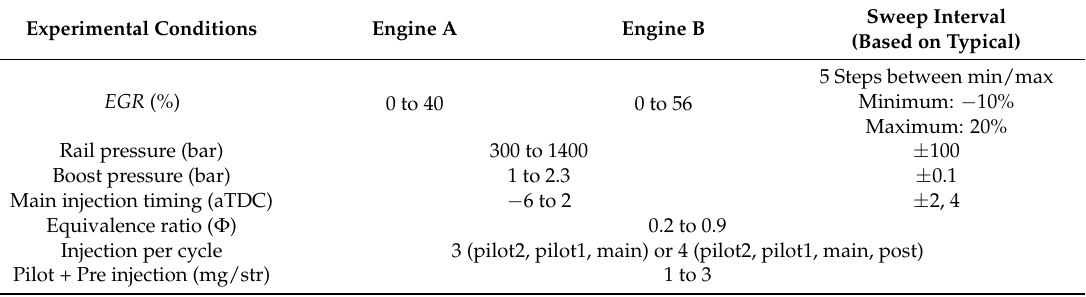
Table 3. Typical engine operating range for steady-state conditions and the sweep interval for each parameter (aTDC means after top dead